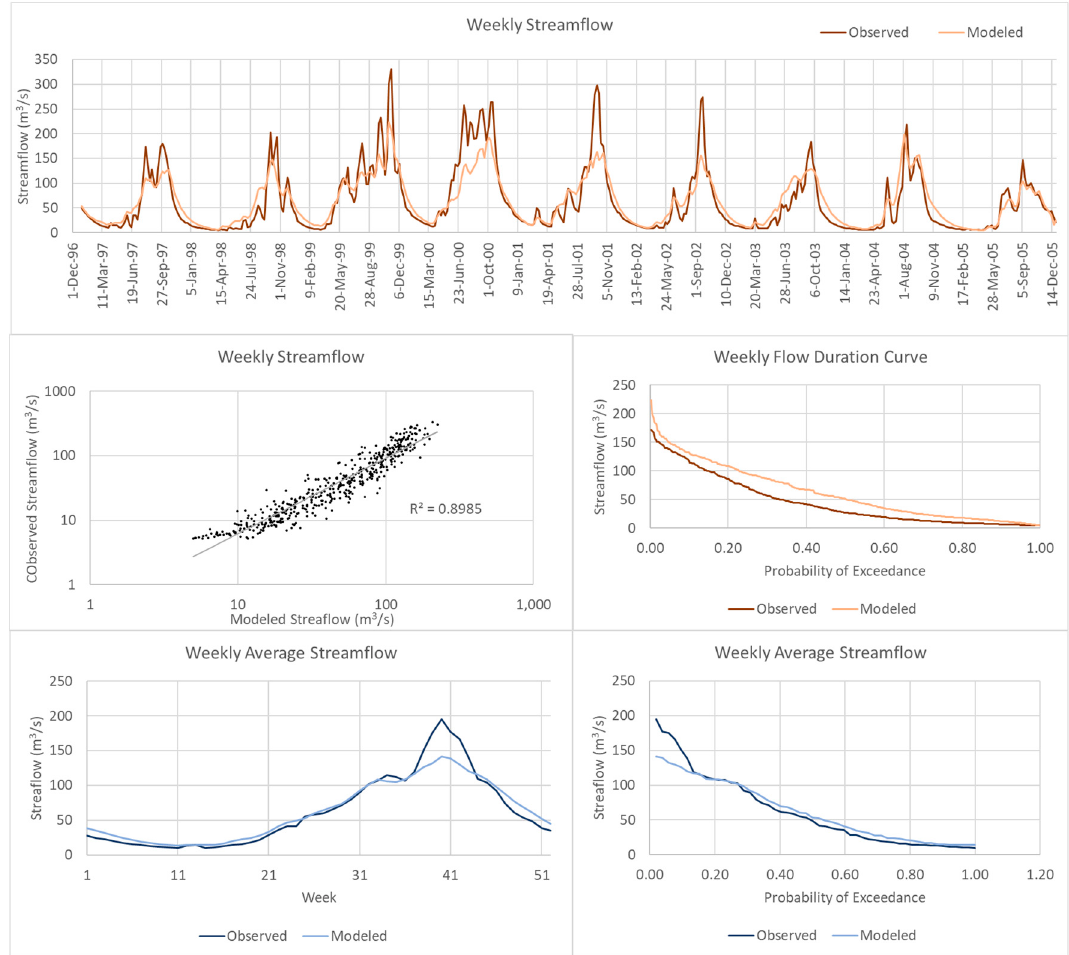
Figure 5. Graphs showing the streamflow calibration of the Stung Chinit model.